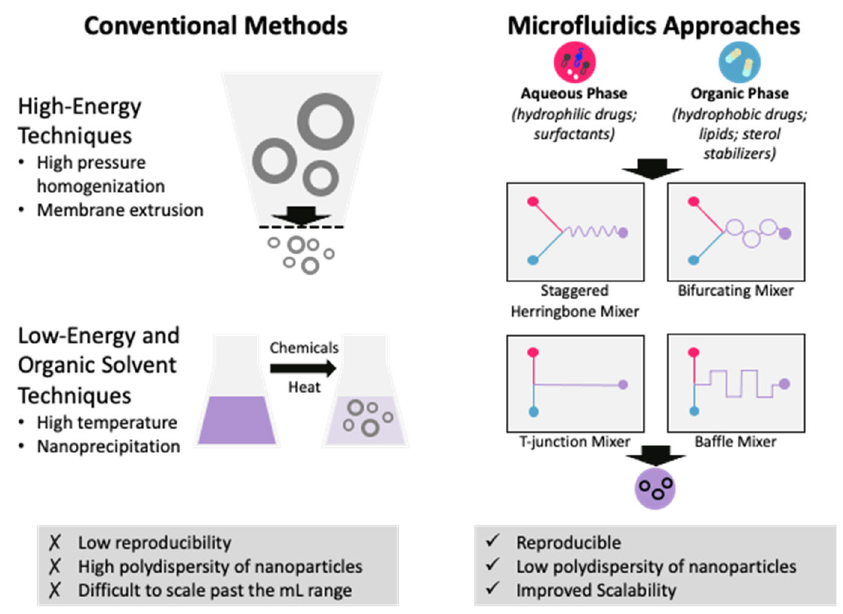
Figure 2. Overview of the microfluidic process to synthesize LBNPs encapsulating drug cargo and comparison with conventional methods.